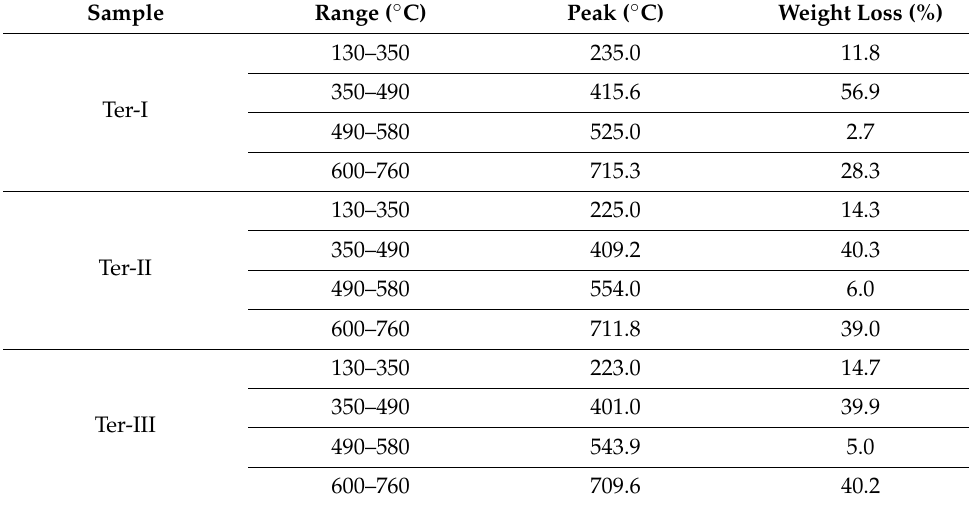
Table 3. Summary of the weight loss characteristics of the terpolymer